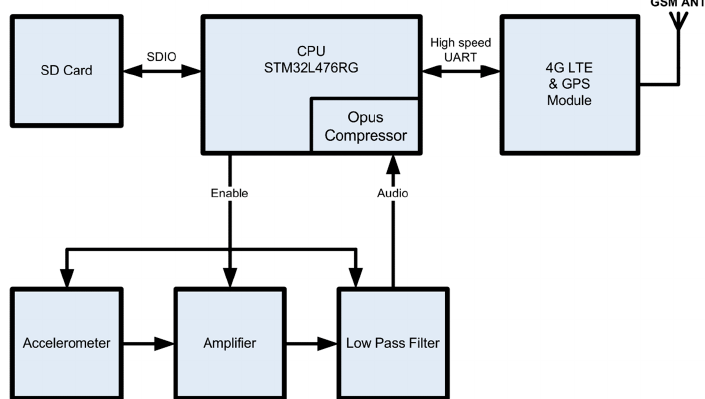
Figure 4. Block diagram of the vibrations recorder. The system is controlled by an STM32L476RG ARM CPU of ST. The 805M1-0020-01 accelerometer picks up the vibrations, that are amplified using the OPA313 and turns them into a line-out signal that is compressed, stored to the SD card and transmitted through the 4G module.